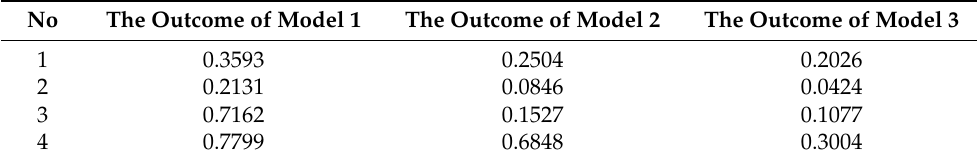
Figure 4. Comparison results of the three models and the real results: ( a ) sample 1; ( b ) sample 2; ( c ) sample 3; ( d ) sample 4. Table 5. Mean of squared errors (MSE) between the predicted value and real